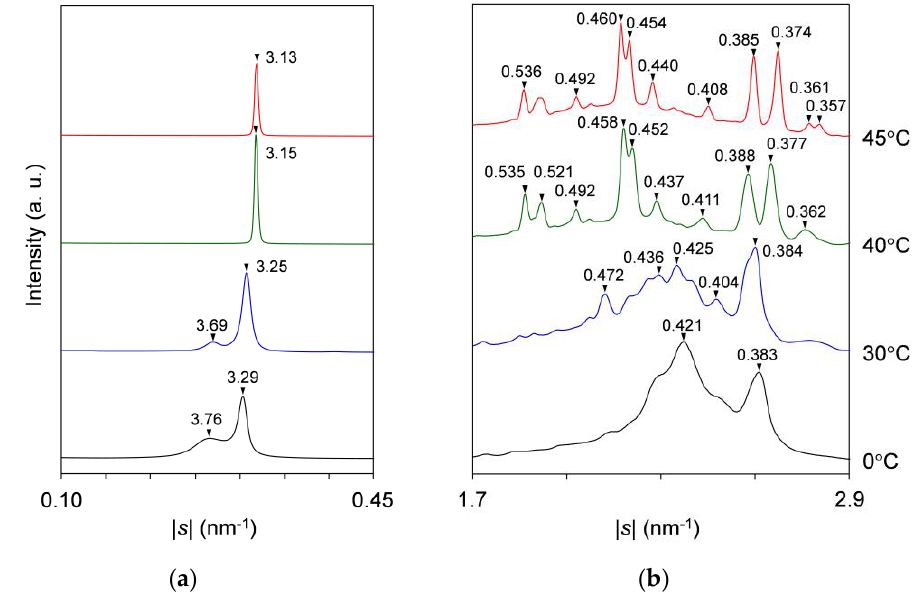
Figure 5. Representative SR-XRD profiles of SOS/LLL ( w LLL = 0.667) in the heating process of Figure 4: ( a ) SAXS; and ( b ) WAXS. Unit: nm.